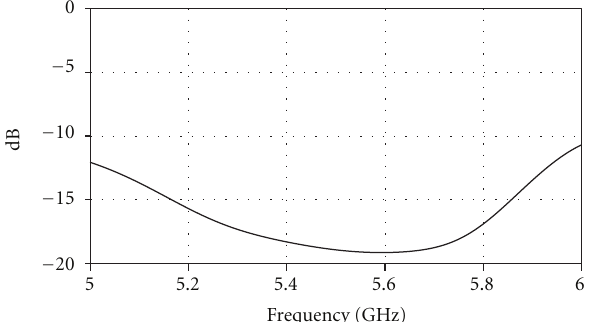
Figure 19: S 11 of the Yagi antenna.